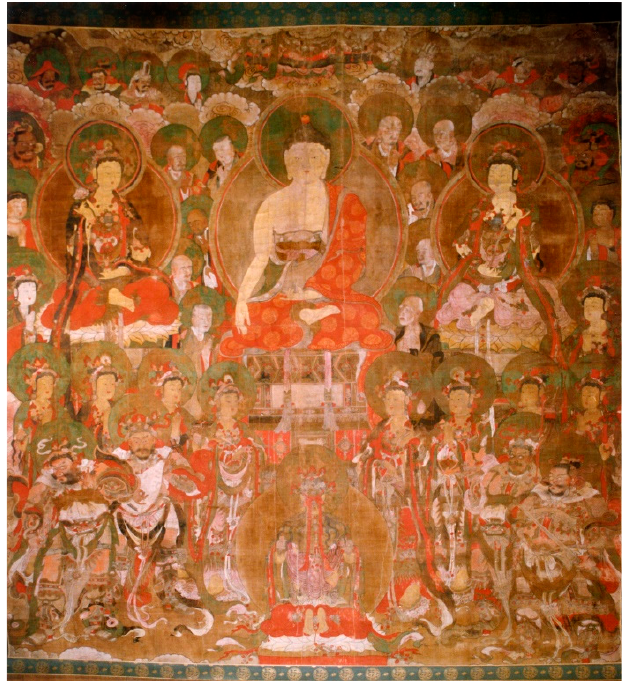
Figure 1. Sakyamuni Preaching (K. Seokga seolbeopdo ), Joseon (16th century), Color on hemp, 278.3 × 276.1 cm, Koshoji Temple in Nagoya, Japan. Photo by Jeong Utaek. From around the mid-seventeenth century to the first half of the eighteenth century, the Listener began to appear again in large outdoor hanging scroll paintings (K. gwaebul 掛佛 ) made at temples in Chungcheong-do Province. Among five gwaebul made in this region at the time, two examples—that painted at Bosalsa Temple 菩薩寺 in Cheongju (1649) (Figure 2) and that painted at Gapsa Temple 岬寺 in Gongju (1650) (Figure 3)— follow sixteenth-century tradition with the Listener appearing in bodhisattva form. Figure 2. Sakyamuni Preaching , Joseon (1649), Color on hemp and silk, 652.7 × 430.5 cm, Bosalsa Temple (Research Institute of Sungbo Cultural Heritage 2000b, p. 27).